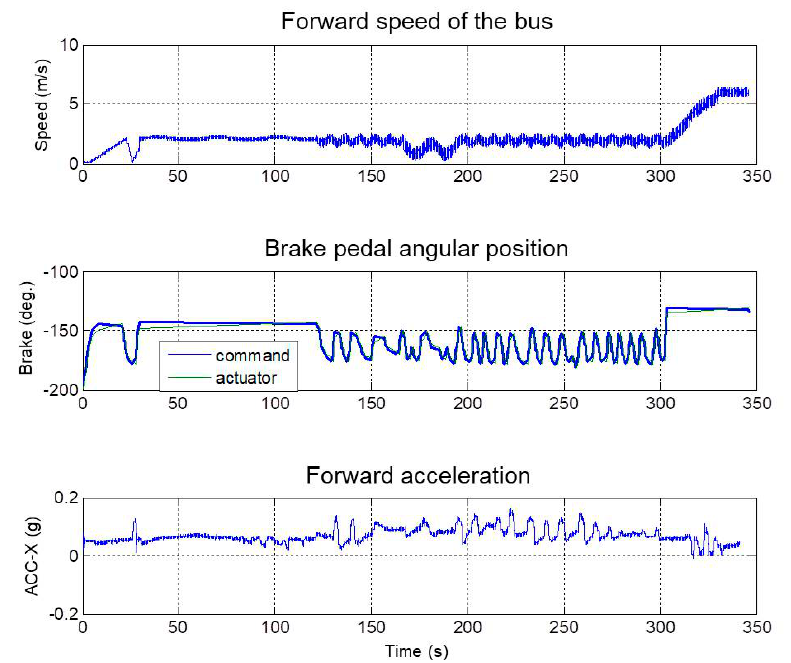
Figure 14. Comparison among bus speed, brake position and x-acceleration during the tracking trajectory. Brake control is applied 25 s after the start and from the times 125 to 300 s to cope with a downslope in the circuit.